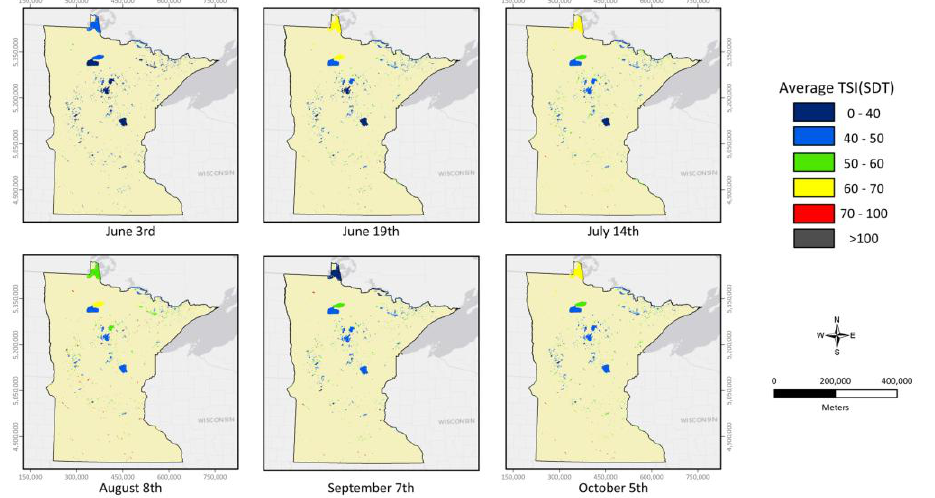
Figure 3. Lake average TSI